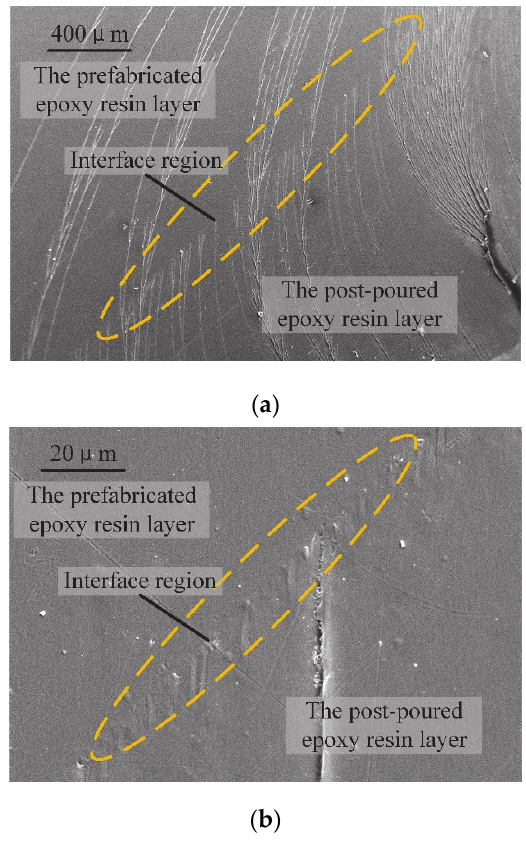
Figure 6. Fracture microstructure of interface sample: ( a ) 50× magnification; ( b ) 1000× magnification.